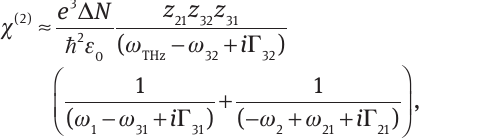
where Δ N is the population inversion density between upper and lower laser states (we assumed here that the populations of the upper states are the same and the populations of the lower states are also the same), and z , ω , and Γ are the dipole matrix element, frequency, ij ij ij and transition linewidth broadening factor between states i and j . Assuming the mid-IR pump frequencies are suf- ficiently close to the corresponding intersubband transi- ≈ ω ≈ ω tions, i.e. ω and ω , the value of χ (2) in Eq. (5) is 1 13 2 12 principally determined by the values of Δ N , the transition dipole moments z , and the linewidth broadening factors ij Γ . The value of Δ N is obtained by computing the required ij population inversion in a DFG-QCL to provide a threshold condition (modal gain = modal loss) in the laser cavity. We assume Δ N ≈ 1.0 × 10 15 cm −3 for the population inversion at = 12.5 meV for the mid-IR room temperature. Assuming Γ ij = 4 meV for the THz transitions and a transitions and Γ ij threshold gain of 15 cm −1 in the active region, we obtain | χ (2) | = 15.1 nm/V for the 9.3 μ m BTC active region design and | χ (2) | = 24.7 nm/V for the DAU active region design at